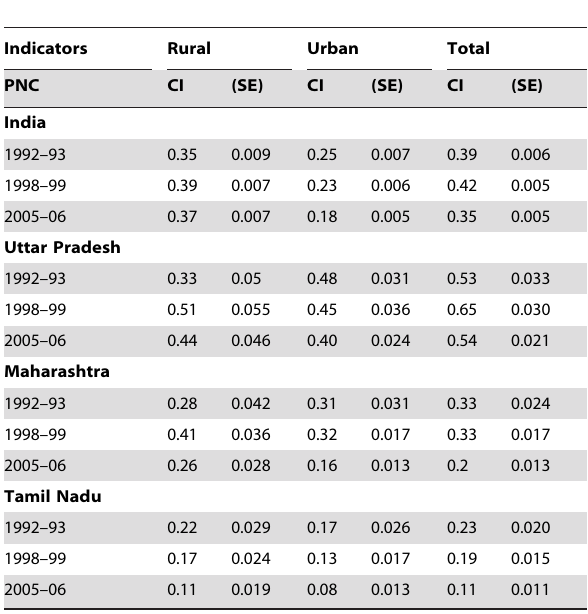
Table 3. Trends in economic inequalities in prenatal care across selected states, India,